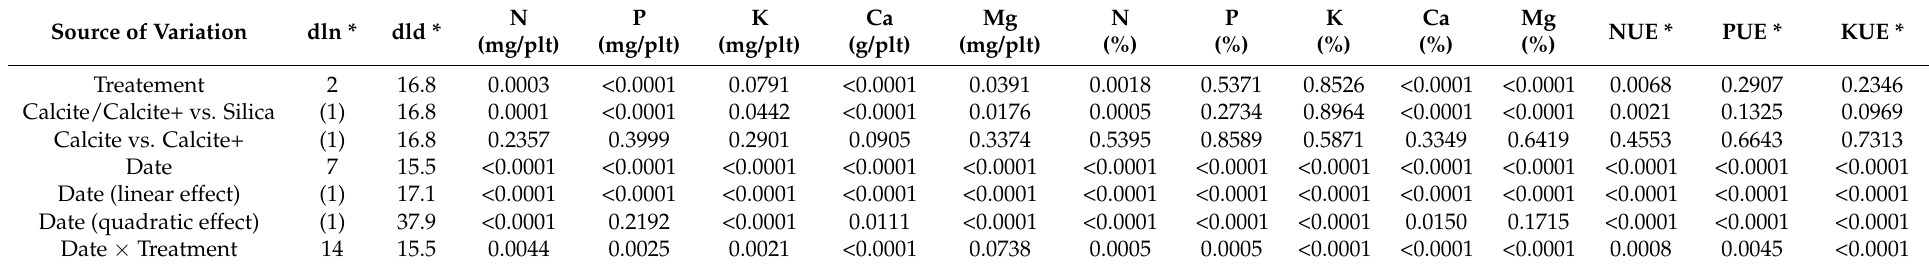
Table 5. Observed probabilities of fixed effects ( p values) associated with analysis of variance for the nutrient content (mg/plant), concentration (%) and nutrient use efficiency of shoot of white spruce seedlings (1 + 0).